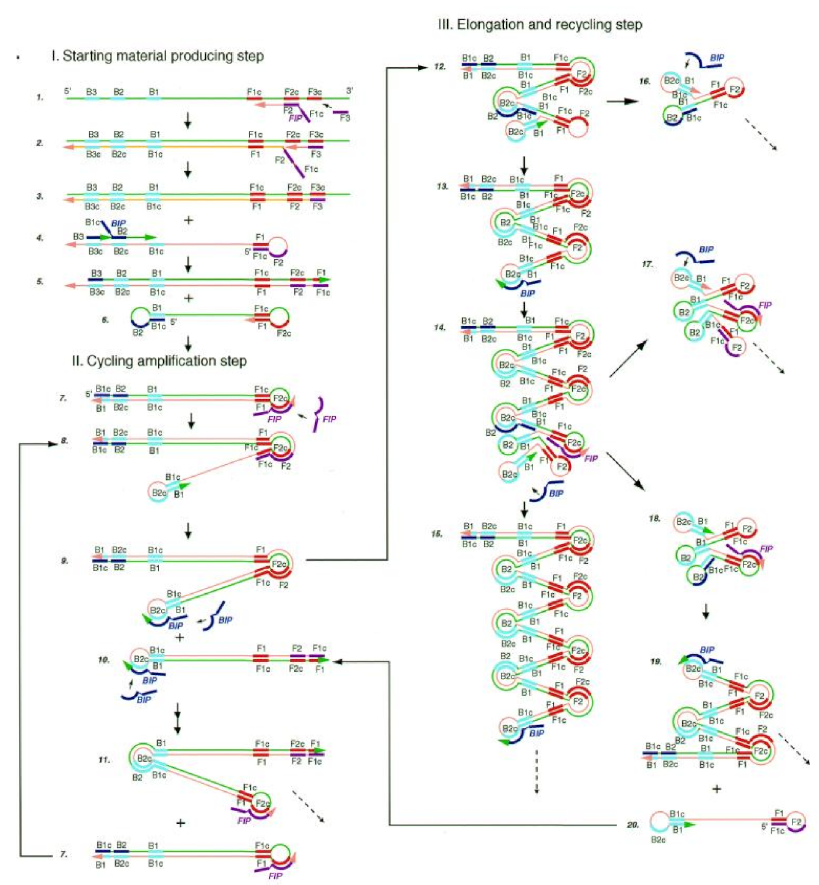
Figure 2. Steps in the LAMP mechanism. A pair of inner primers (BIP) with a folding structure and a pair of outer primers (FIP) for replacing single-strand products are required. Under the action of FIP, BIP and the Bst DNA polymerase with chain displacement activity, dumbbell intermediate products with a ring structure at both ends are generated. The amplification products of dsDNA concatemers were amplified by the double action of initiating extension in the ring region of the BIP recognition intermediate and self-initiating extension at the 3 (cid:48) end of the folding structure. Reprinted with permission from Ref. [15]. Copyright 2018, Wong et